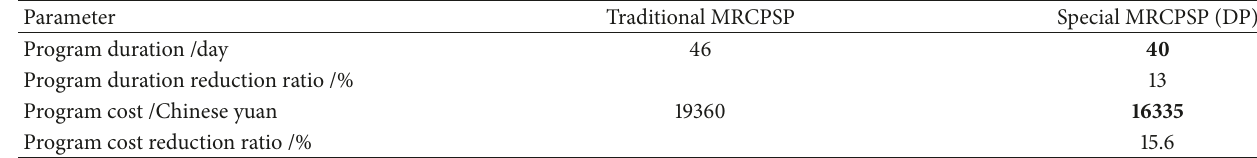
Table 10: Comparison of two models (real-life instance).